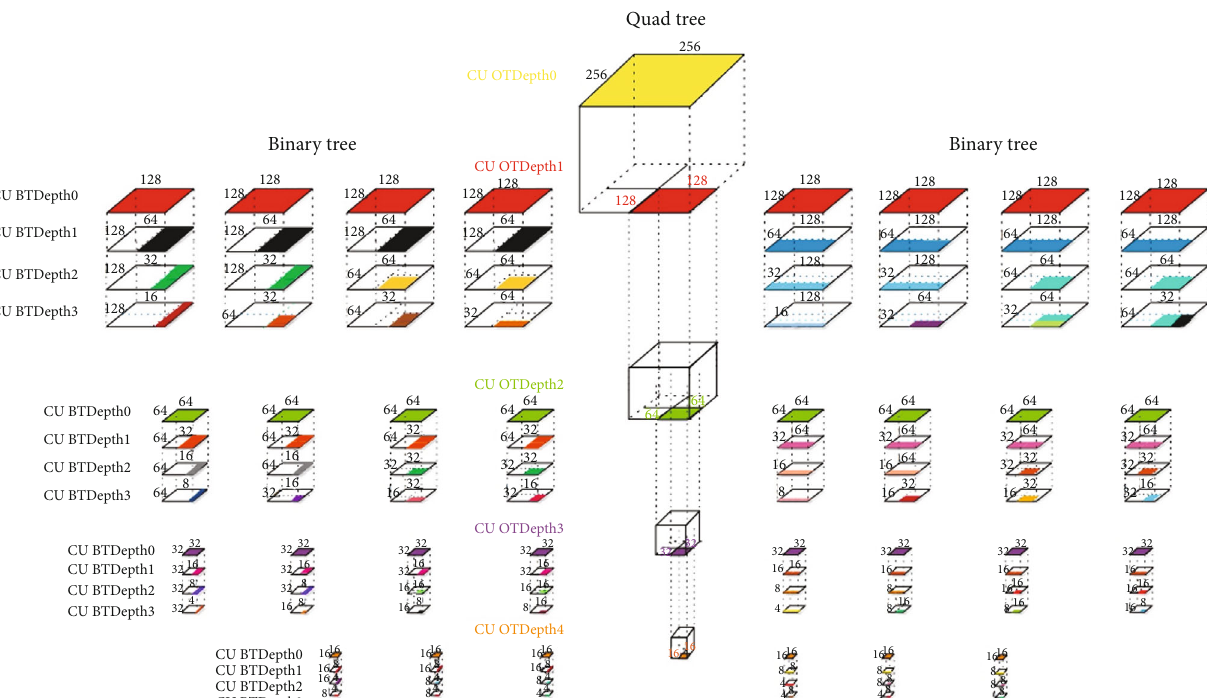
Figure 3: Quadtree plus binary tree